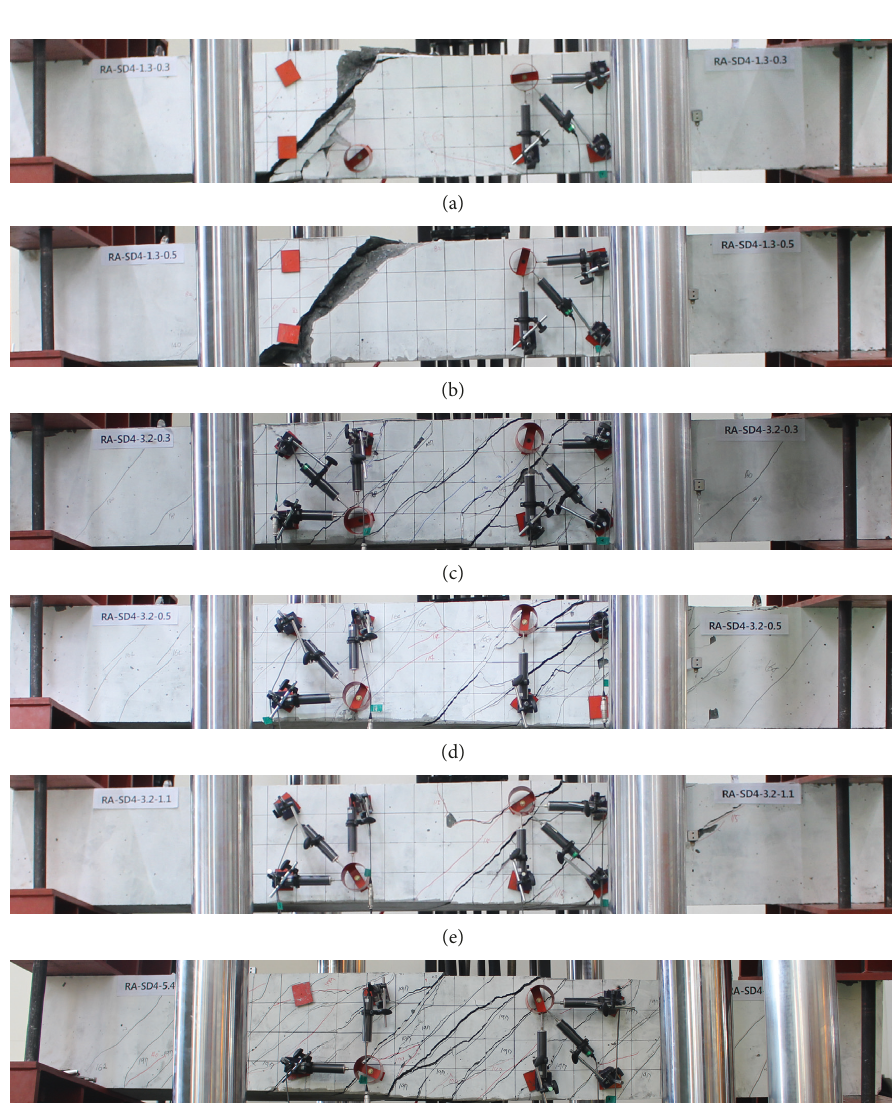
Figure 5: Cracking patterns of high-strength beams reinforced by SD400 bars. (a) Series 1: RA-SD4-1.3-0.3-1.62. (b) Series 2: RA-SD4-1.3- 0.5-0.92. (c) Series 3: RA-SD4-3.2-0.3-3.28. (d) Series 4: RA-SD4-3.2-0.5-2.13. (e) Series 5: RA-SD4-3.2-1.1-1.33. (f) Series 6: RA-SD4-5.4-